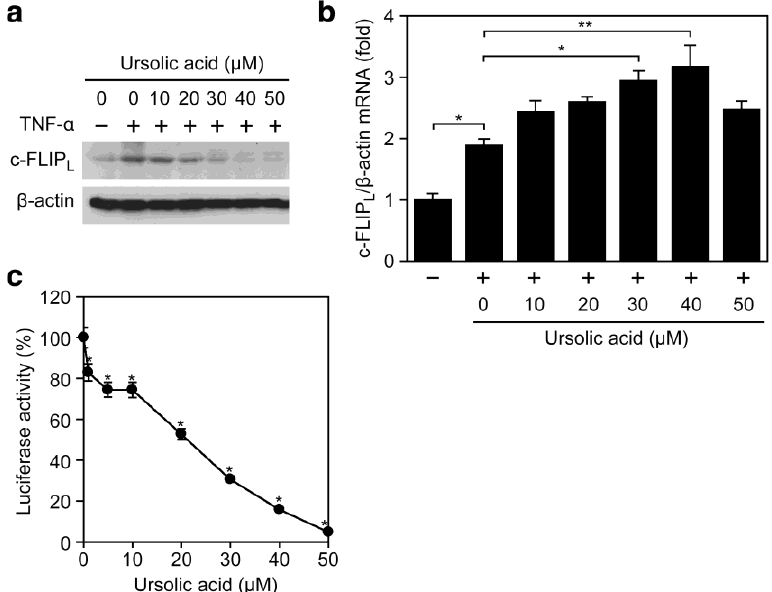
Figure 4. Ursolic acid inhibits TNF-α-induced expression of NF-κB-responsive genes. ( a ) A549 cells were preincubated with various concentrations of ursolic acid for 1 h and then incubated with (+) or without (–) TNF-α (2.5 ng/mL) for 6 h in the presence or absence of ursolic acid. Protein expression of c-FLIP was analyzed by Western blotting; L ( b ) A549 cells were pretreated with indicated concentrations of ursolic acid for 1 h and then incubated with (+) or without (–) TNF-α (2.5 ng/mL) for 6 h in the presence of ursolic acid. c-FLIP mRNA expression was measured by quantitative RT-PCR. The ratio of L c-FLIP mRNA relative to β-actin mRNA is shown as means ± SD (n = 3). * P < 0.05 and L ** P < 0.01, compared with control; ( c ) A549 cells were transiently transfected with the NF-κB-responsive luciferase reporter for 24 h. The cells were preincubated with various concentrations of ursolic acid for 1 h and then incubated with TNF-α (2.5 ng/mL) for 6 h in the presence of ursolic acid. Cell lysates were prepared and their luciferase activities measured. Luciferase activity (%) is shown as means ± SD (n = 3). * P < 0.01, compared with control.